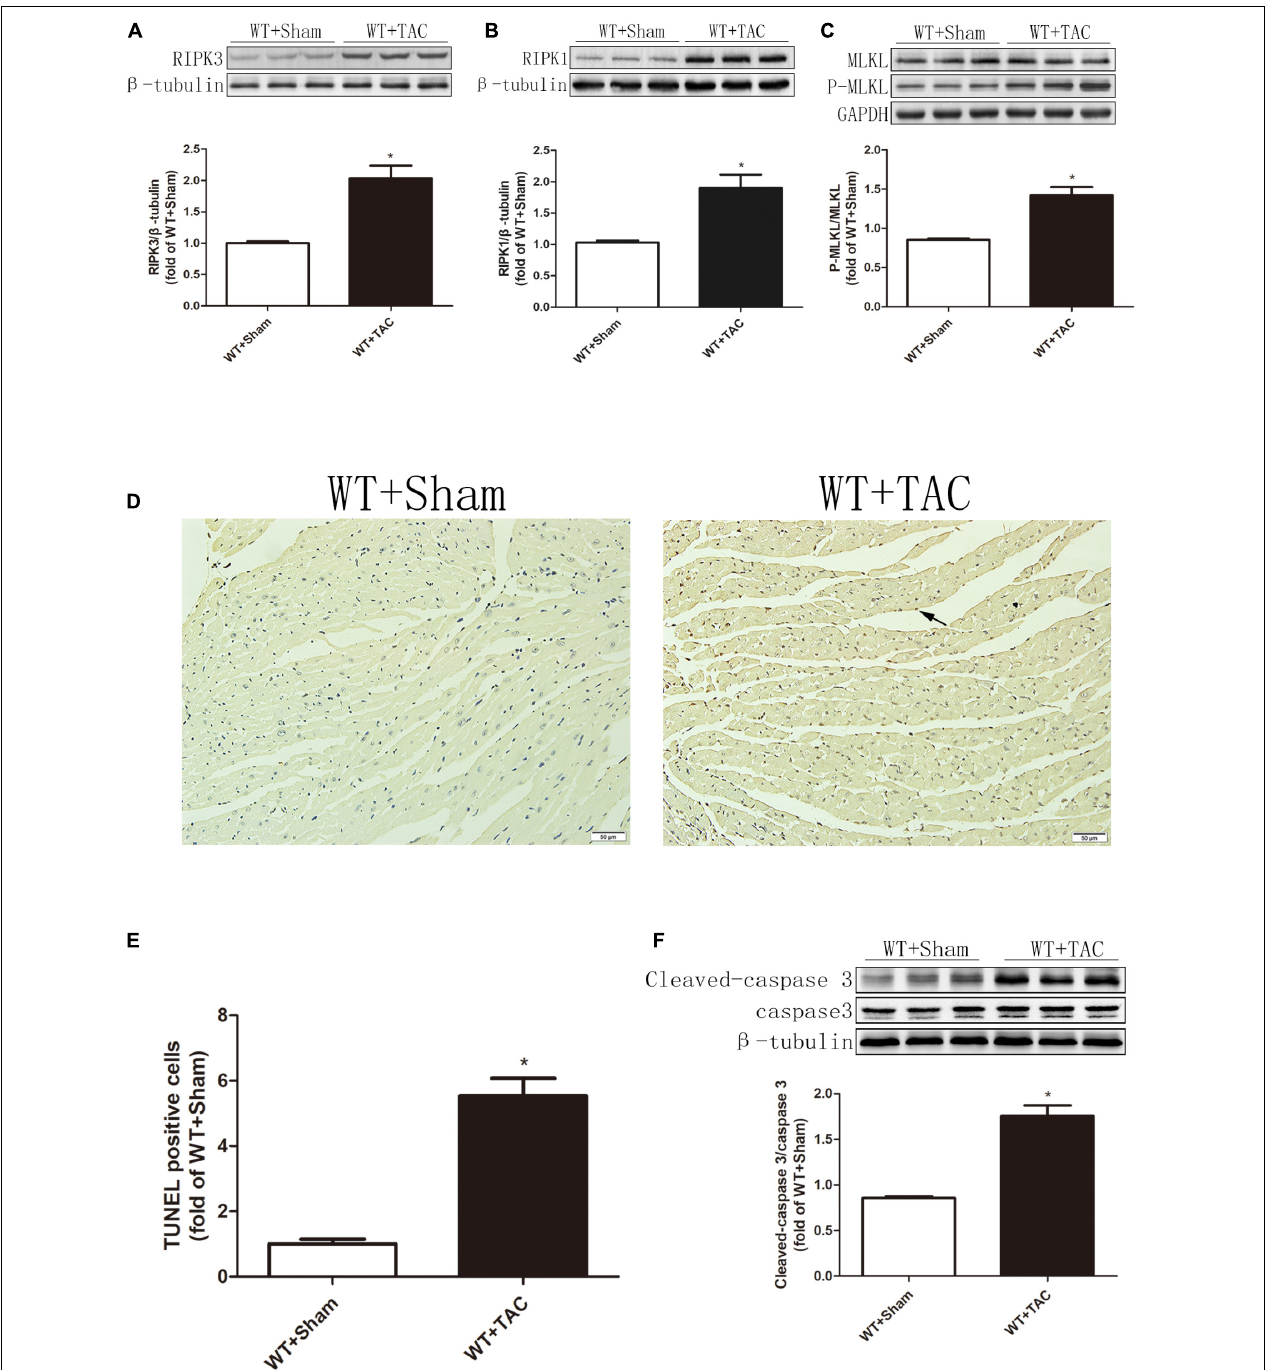
FIGURE 2 | The expressions of RIPK3 and RIPK1, as well as the levels of MLKL phosphorylation and apoptosis, are increased in HF mice. Male 8-week-old C57BL/6 mice were treated with TAC using a 28-g needle. The control group received sham surgery. All groups of mice were given continuous feeding for 6 weeks. Hearts were then obtained for correlative testing. (A) The expression of RIPK3 at the protein level in myocardial tissue was detected by Western blotting analysis, and β -tubulin was used as a loading control. (B) The expression of RIPK1 at the protein level in myocardial tissue was detected by Western blotting analysis, and β -tubulin was used as a loading control. (C) The levels of MLKL and P-MLKL proteins in myocardial tissue were detected by Western blotting analysis, and GAPDH was used as a loading control. (D) The level of apoptosis in myocardial tissue was measured by TUNEL staining, bar = 50 µ m; (E) The statistical chart of TUNEL-positive cells. (F) The levels of cleaved caspase 3 and caspase 3 in myocardial tissue were detected by Western blotting analysis, and β -tubulin was used as a loading control. Compared with WT + sham group, * P < 0.05. n = 6.